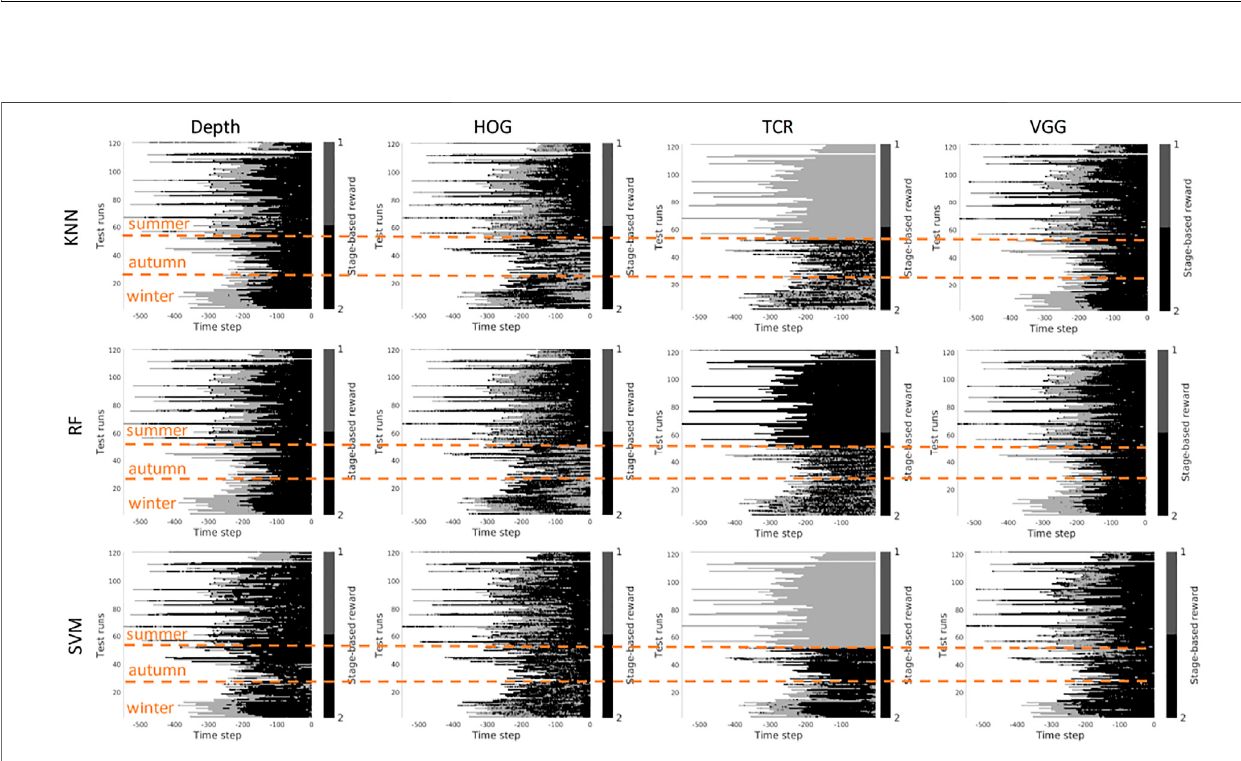
Frontiers in Robotics and AI |